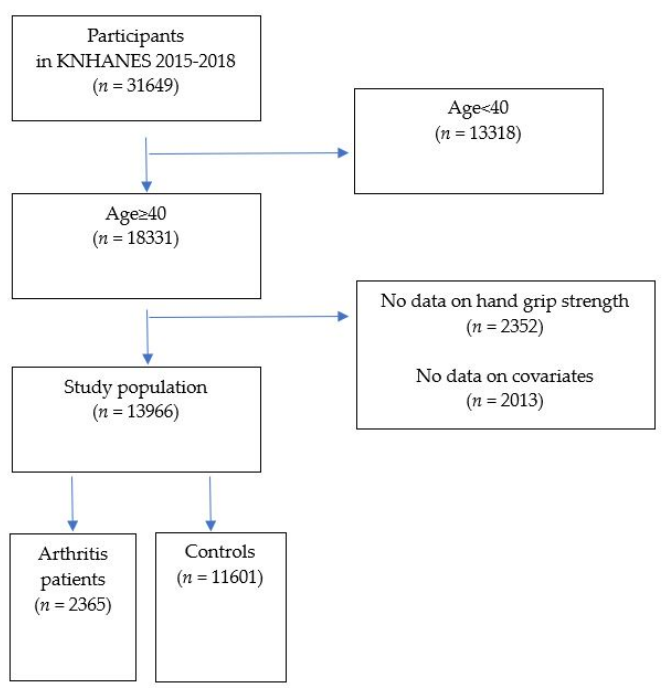
Figure 1. Flow diagram of participant selection.